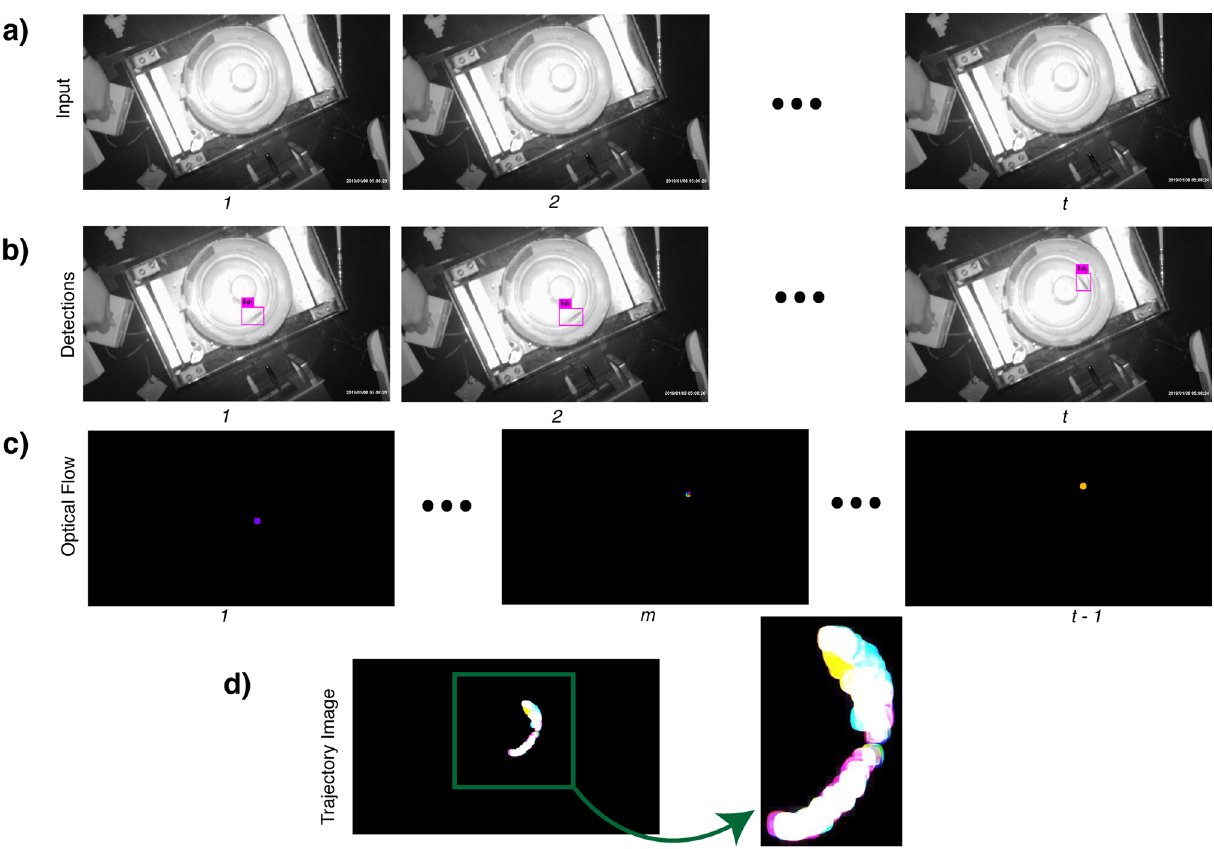
Figure 1. Process used to generate a trajectory image from experimental data. This figure illustrates the first two steps, fish detection and tracking, of the software pipeline that forms the proposed tool. The process includes ( a ) Selection of raw input video frames; ( b ) automatic detection of a fish within each video frame; ( c ) tracking of the fish via optical flow; ( d ) creation of a trajectory image combining the optical flow output of the video frames, which is provided to an autoencoder for compression. We use the latent representation from the autoencoder for classification. That process is shown in Fig. 2. The numbers 1, 2, . . . , t just beneath the images stand for different timestamps of the video frames. Since the optical flow algorithm operates on two consecutive frames, the total number of frames after processing by the algorithm is t − 1